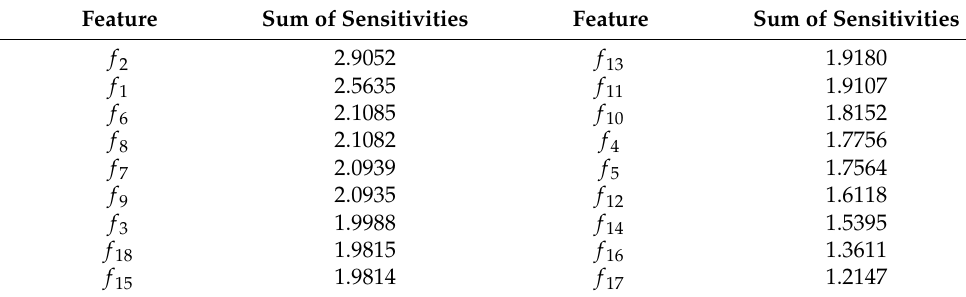
Figure 11. Sensitivity analysis of the feature set. Table 5. The sorting results of feature sensitivity.